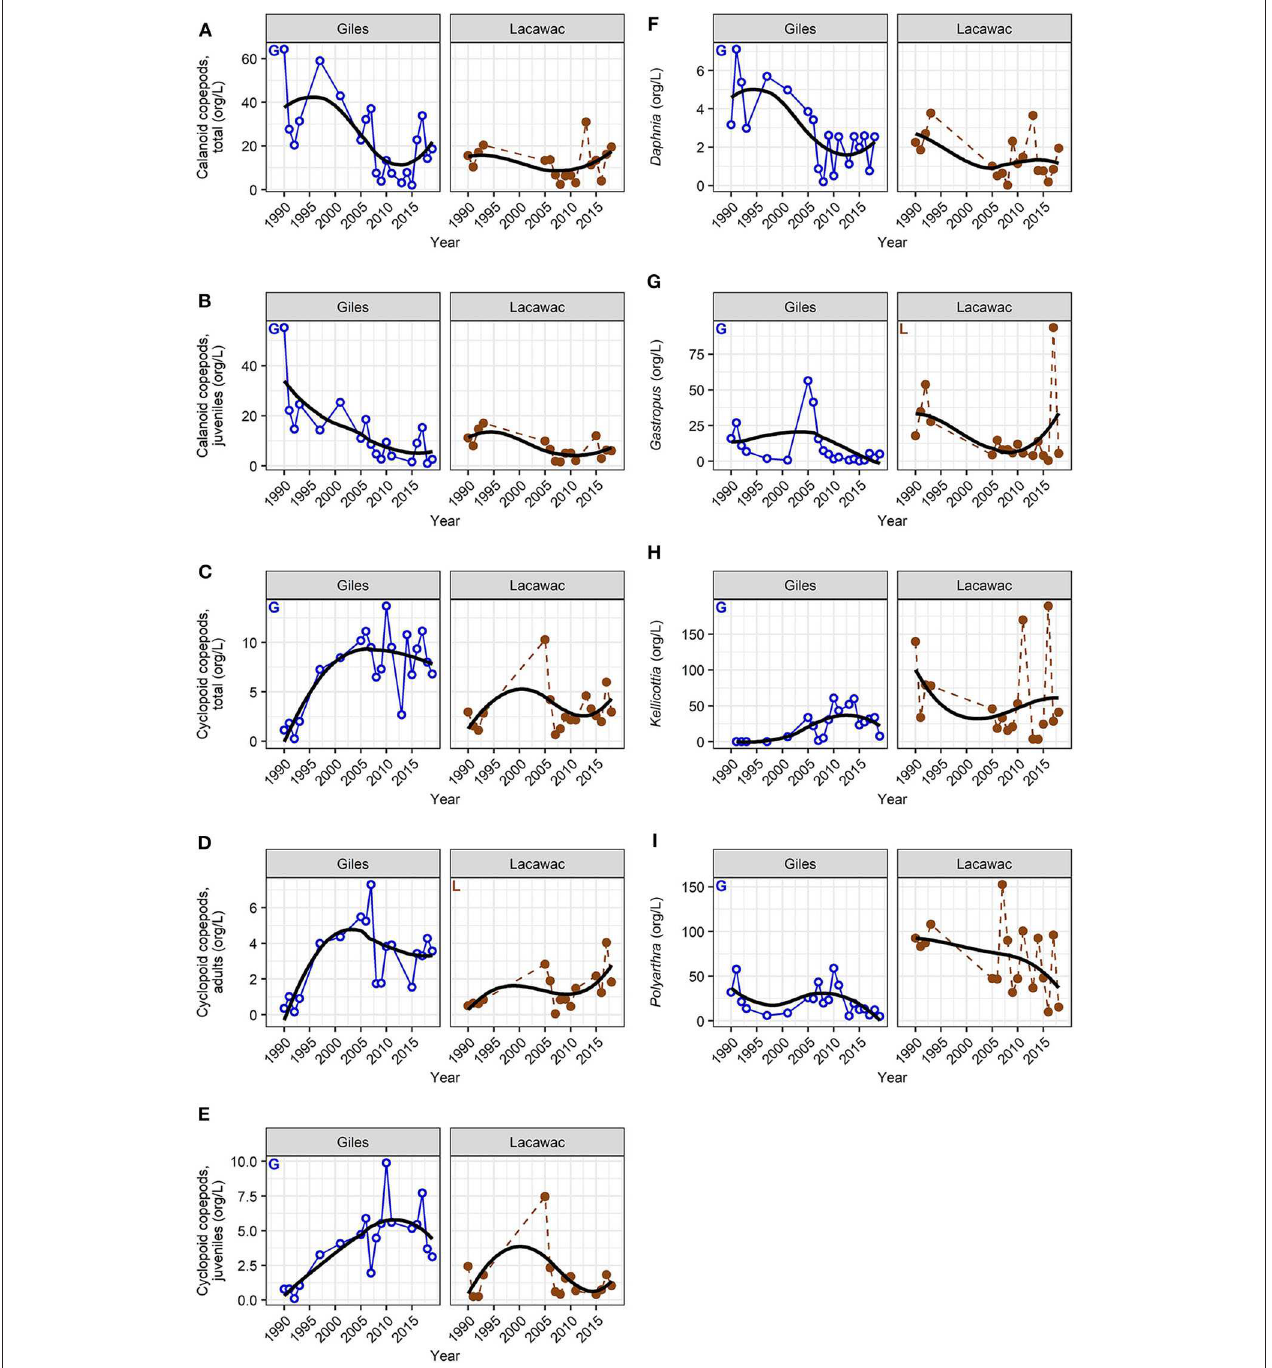
FIGURE 6 | Long-term summer average (June, July, August) changes in zooplankton abundance (A–I) in Lake Giles (blue, open circles with solid line), and Lake Lacawac (brown, filled circles with dashed line). Letters indicate statistically significant long-term trends in Giles (“G”) and in Lacawac (“L”; Mann-Kendall non-parametric trend test, p < 0.05). Black trend lines are LOESS smoothed lines.